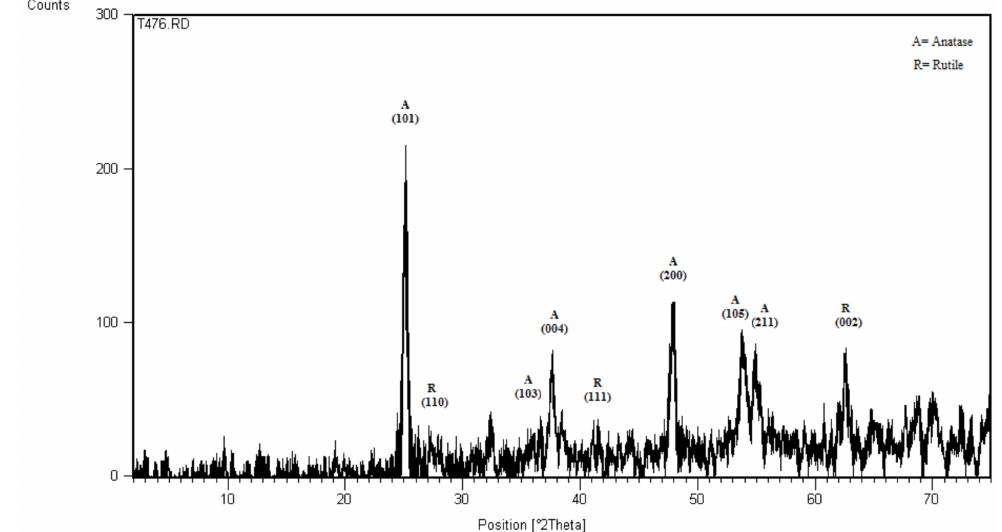
Figure 1. X-ray diffraction (XRD) pattern of the prepared N-doped TiO 2